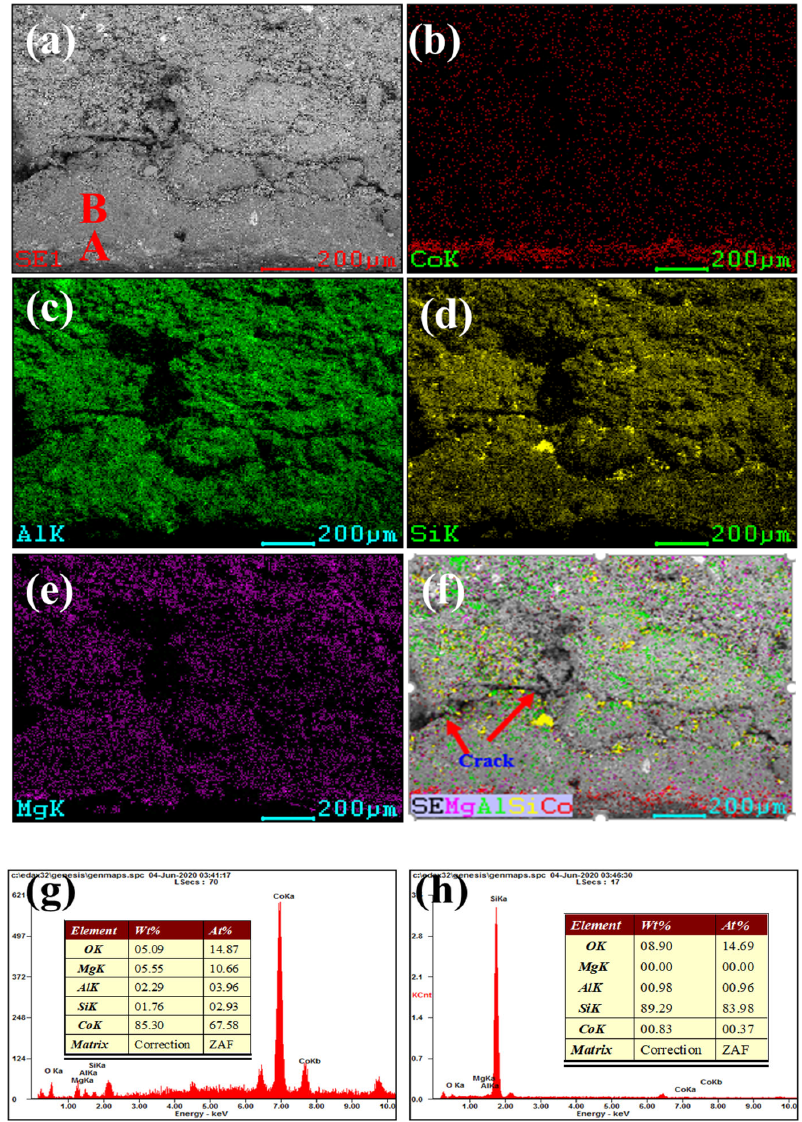
Figure 4. SEM and EDS mapping photos of a section of waste saggar. ( a ) SEM image of a sample magnified 200 times; ( b ), ( c ), ( d ), and ( e ) EDS mappings of Co, Al, Si, and Mg elements, respectively, in ( a ); ( f ) composite of ( a – e ); ( g ) and ( h ) EDS images of positions A and B, respectively, in ( a ).